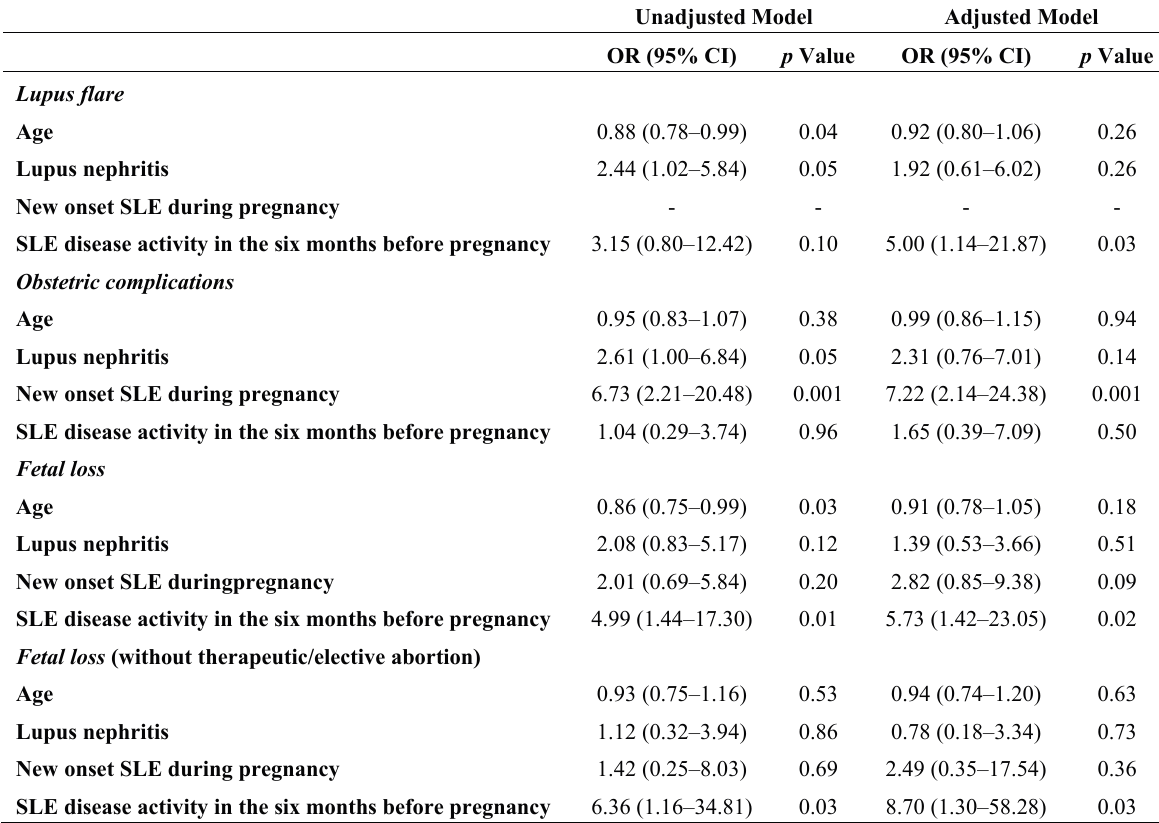
Table 6. Risk factors for lupus flare, obstetric complications and fetal loss in pregnant women with